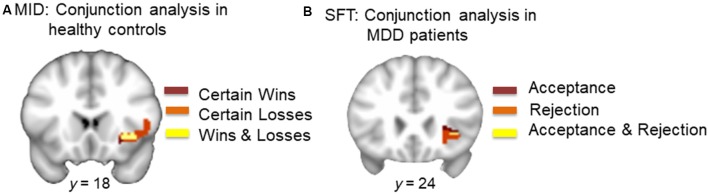
(A) Conjunction analysis of monetary wins and losses in HCs. Dark red represents voxels in the right AI during certain wins (minus neutral). Orange represents voxels in the right AI during certain loss (minus neutral). Yellow represents overlapping voxels in the AI during both win and loss (center of mass: x = 36.6, y = 21.5, z = −3.8, k = 126). (B) Conjunction analysis of acceptance and rejection in MDD patients. Dark red represents voxels in the right AI during acceptance (minus neutral). Orange represents voxels in the right AI during rejection (minus neutral). Yellow represents overlapping voxels in the AI during both social acceptance and social rejection (center of mass: x = 35.6, y = 24.4, z = −2.0, k = 5).